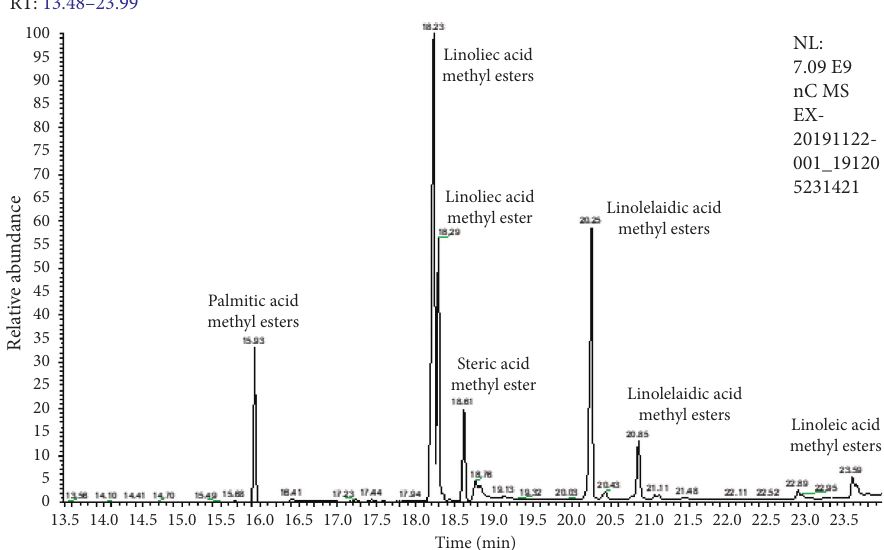
Figure 11: Chromatogram of MMEs catalyzed by chicken eggshell ash-derived CaO (refer to Supplementary Data Section